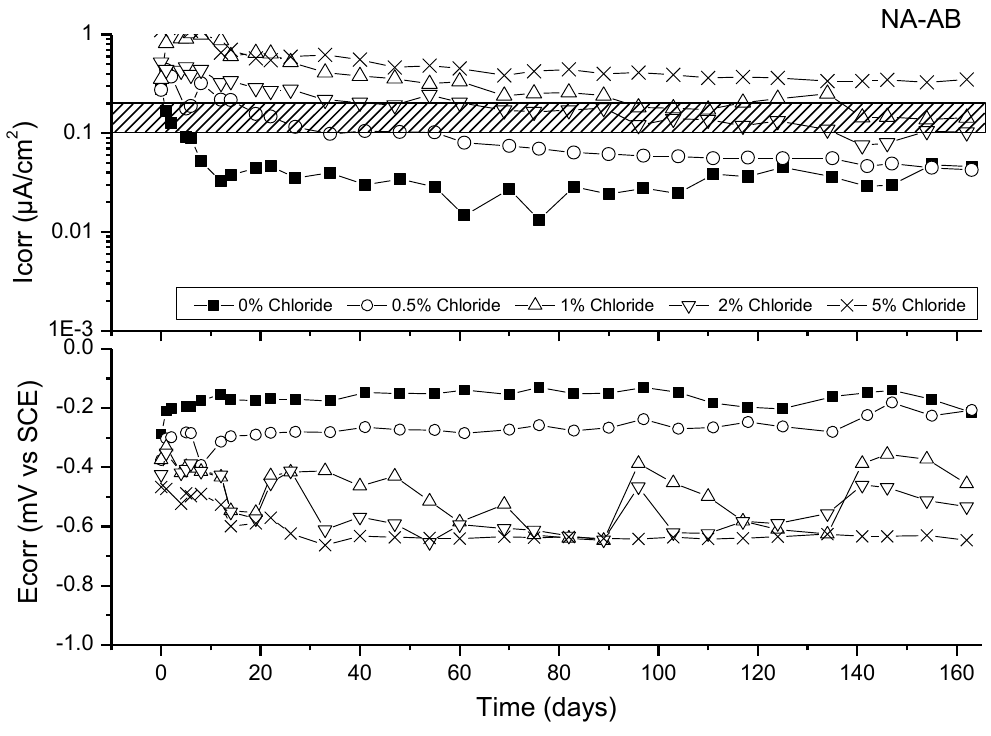
Figure 8. Corrosion rate and corrosion potential of steel reinforcement embedded in NA-AB specimens and different chloride